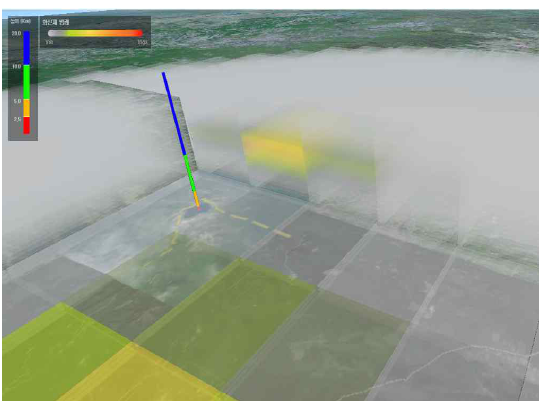
Figure 5. 3D visualization result with "Cube in the Air" method-2